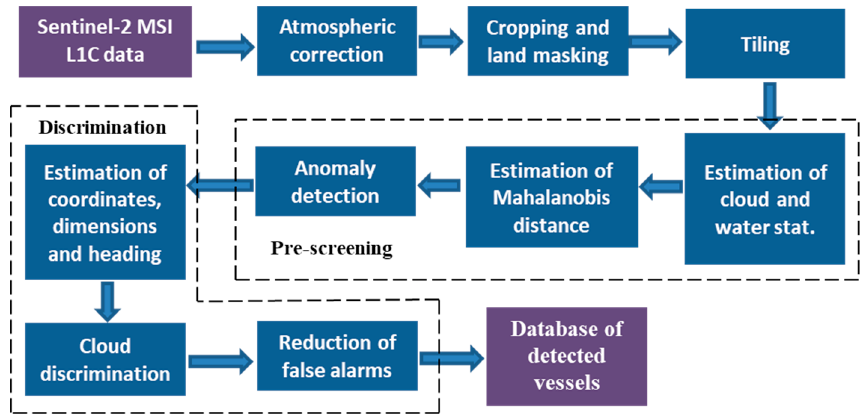
Figure 7. Sentinel-2 Multispectral Instrument (MSI) data processing chain.